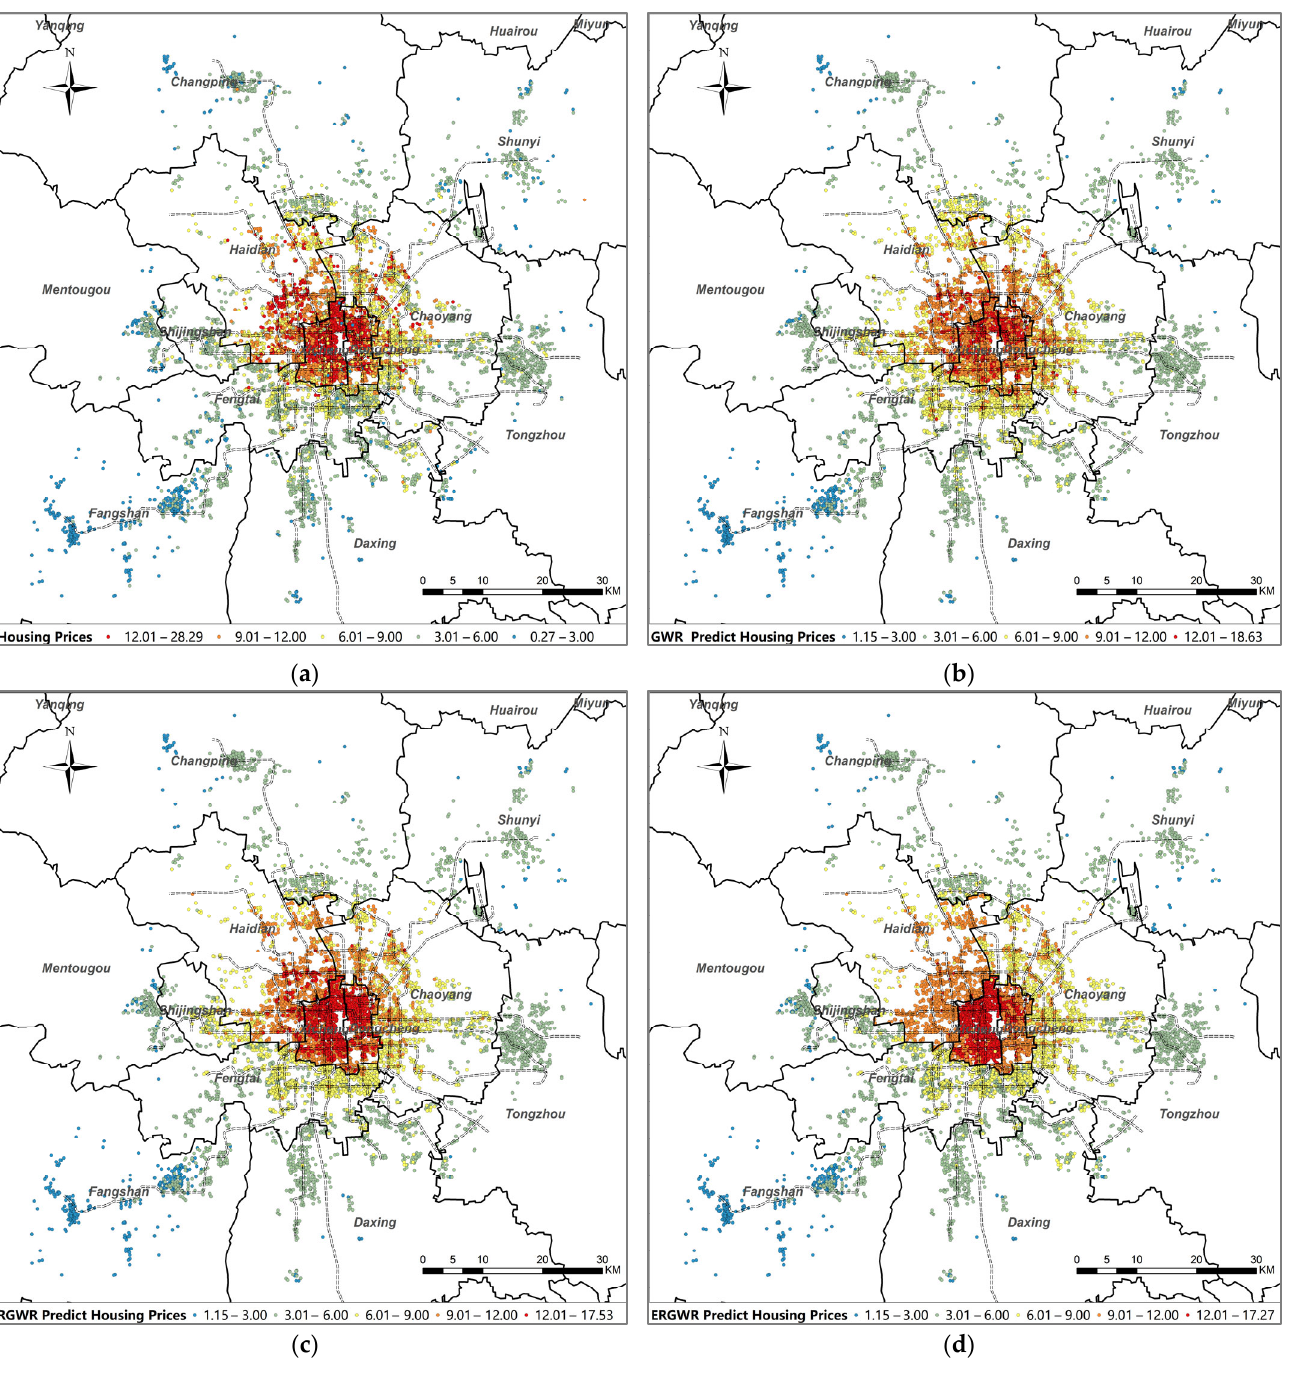
Figure 7. Actual housing prices and the housing prices predicted by different models. ( a ) Commercial housing prices in Beijing; ( b ) housing prices predicted by the GWR model; ( c ) housing prices predicted by the RGWR model; and ( d ) housing prices predicted by the E ‐ RGWR model. We chose the confluence area of Shijingshan, Haidian, and Fengtai for close ‐ up com ‐ parison between different models, as shown in Figure 8. It can be clearly seen that, in the actual housing price distribution, there is an obvious spatial discrete phenomenon in the intersection of the three regions. The housing prices in Haidian are concentrated above 90,000 yuan, while those in Shijingshan and Fengtai are mostly below 90,000 yuan. The